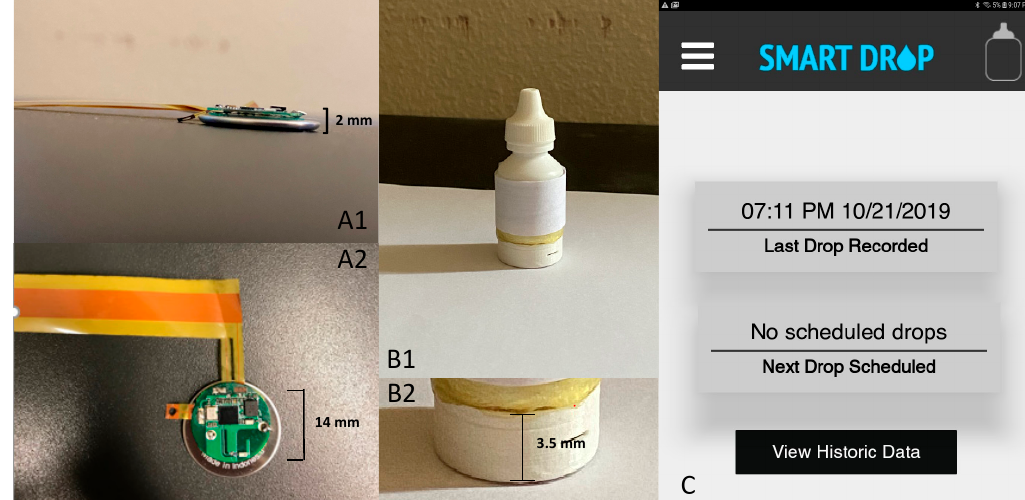
Figure 1. ( A1 ) Lateral view of electronics underlying the smart drop system, comprising a thin conductive pressure-sensitive electronic sensor, for bottle squeezing detection and an electronic circuit (<2 mm thick) for signal processing and wireless transmission. ( A2 ) Top view of electronic sensor and electronics placed beneath the bottle. The circuit diameter and battery are approximately 14 mm in diameter. ( B1 ) An eyedrop bottle containing the flexible sensor underneath the label, and electronics at the base of the bottle. ( B2 ) Plastic case (height 3.5 mm) underneath an eyedrop bottle that covers the battery and the circular electronic circuit. ( C ) Smart phone application that communicates via Bluetooth Low Energy (BLE) with the instrumented eyedrop bottle to track eyedrop adherence. The application can update patient adherence information to a database (Google) where individuals (e.g., physicians, care providers, family members) can track how the patient adheres. The database also allows for real-time updating of reminder specifications on the smart phone app, so that programed reminders for patients can be modified remotely.